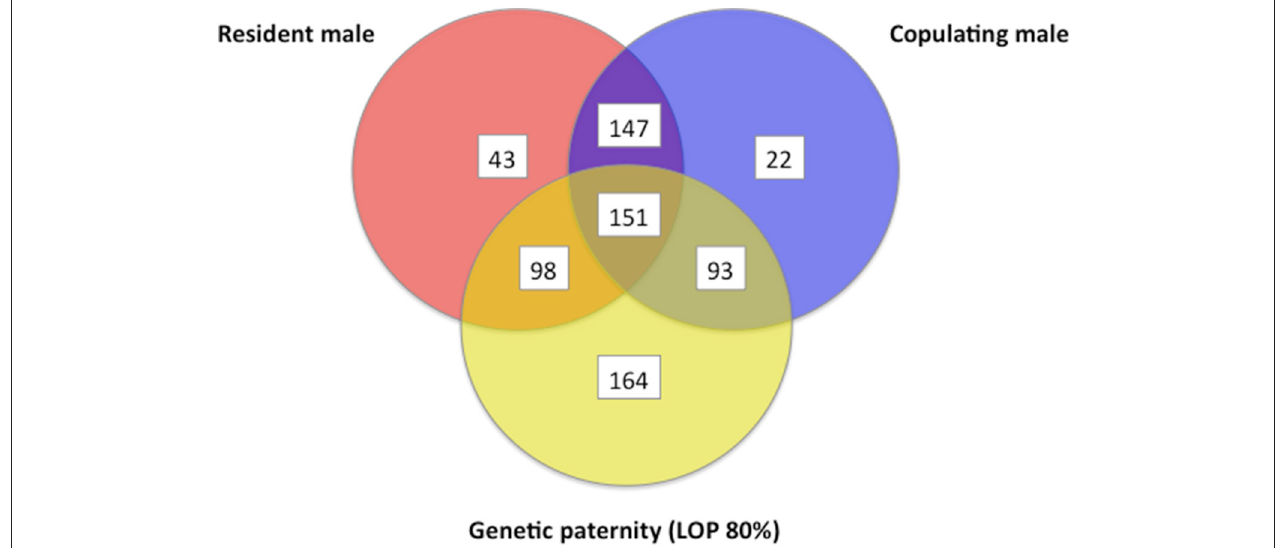
FIGURE 12 | Venn diagram that shows information about a female’s sexual partner(s) regarding (a) whether the male was a resident of the female’s home territory, (b) whether the male was observed to copulate, and (c) whether the male had the highest likelihood of paternity (LOP), as determined by seven polymorphic